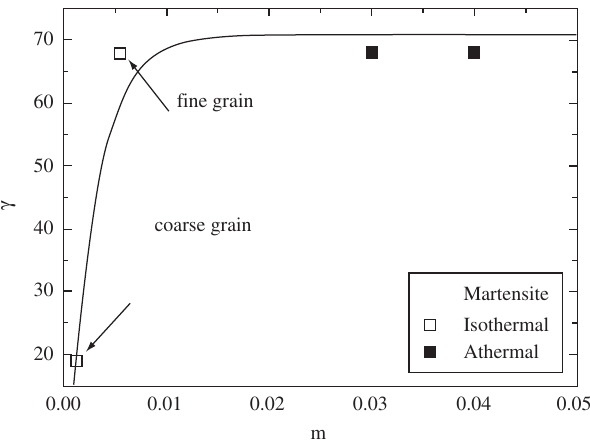
Figure 7. γ , i. e., the number of grains of the spread event or cluster of partially transformed grains of the parent matrix plotted against m, the ratio of the volume of a pioneer plate, v, to the grain volume, q 16 . Values of γ for Fe-23.4 wt. (%) Ni- 2.8 wt. (%) Mn, isothermal martensite, were obtained from Table 2. For Fe-31 wt. (%) Ni-0.02 wt. (%) C, athermal martensite, γ was taken from previous work 1 . The solid line depicted in the figure is just a guideline, not a theoretical